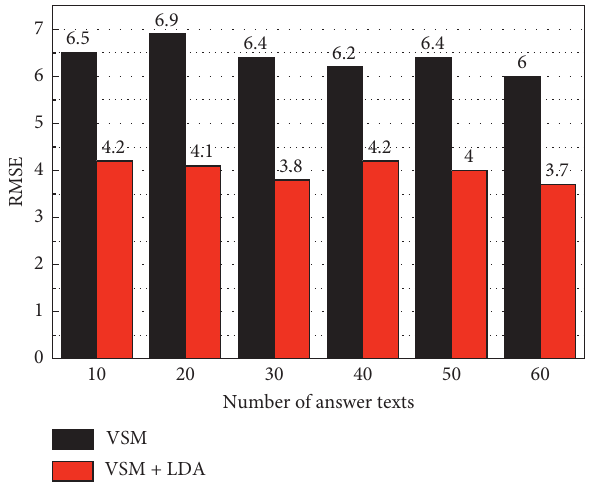
Figure 6: Comparison of scores of sample application